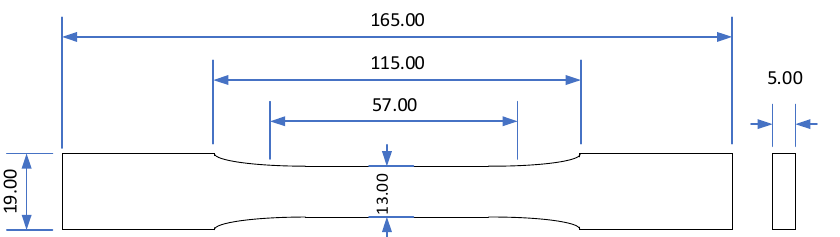
Figure 1. Dimensions of dogbone samples in accordance with ASTM D638-14 [17]. All dimensions in mm.